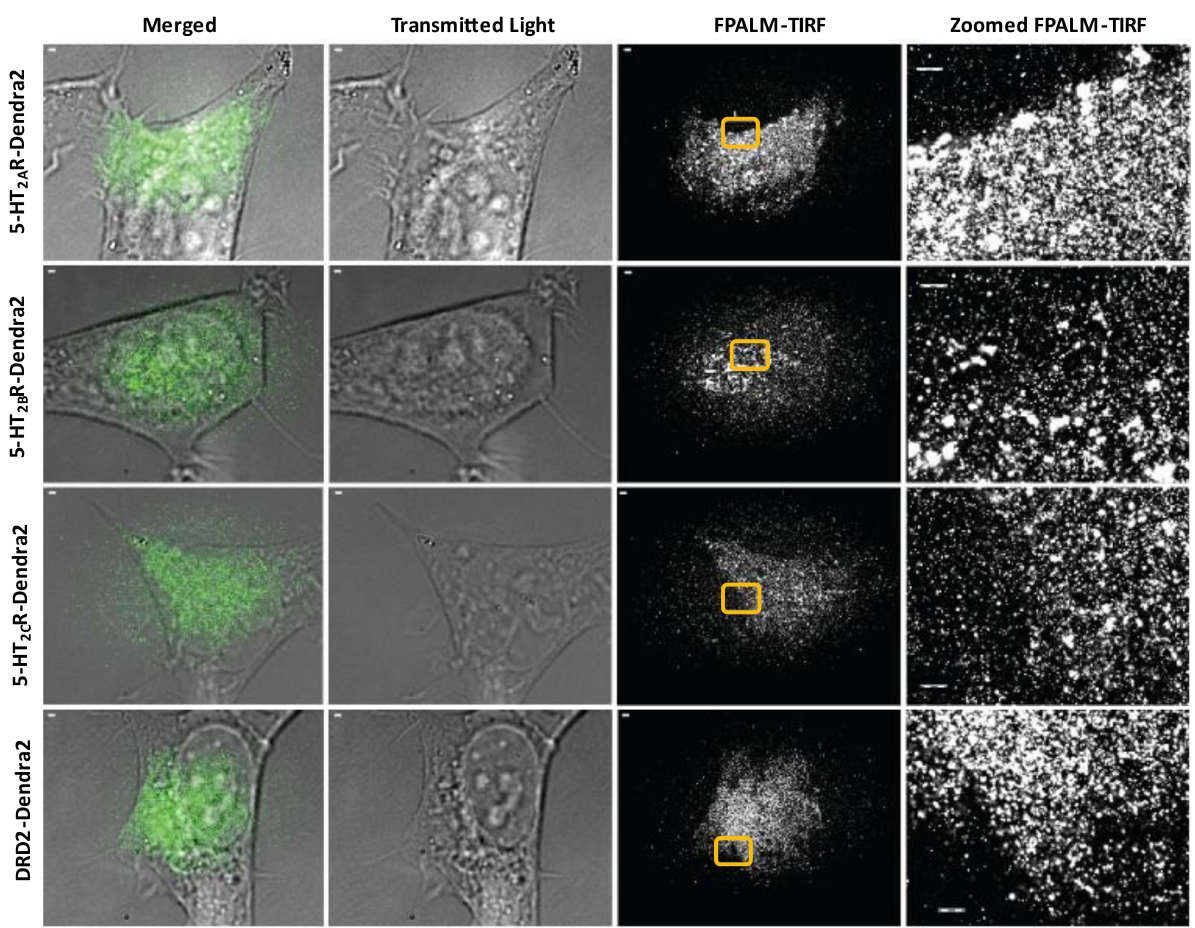
Figure 2. Surface expression of 5-HT 2 R-Dendra2 fusion proteins using FPALM-TIRF microscopy. HEK293A stable cells expressing 5-HT 2A R-Dendra2, 5-HT 2B R-Dendra2, 5-HT 2C R-Dendra2, and DRD2-Dendra2 (green) were analyzed using super-resolution localization microscopy (FPALM) with TIRF illumination (individually represented by each row). Columns represent images acquired using different channels, with column of merged images on the left followed by column of transmitted light images and column of FPALM-TIRF images for each sample. Rightmost column represents zoomed-in regions of interest (yellow box) in FPALM-TIRF images for individual samples. Images were obtained using an Olympus IX71 with 60 × 1.45 NA TIRFM objective, excitation with a 561 nm laser, and activation with a 405 nm laser. Raw image stacks were acquired with an Andor iXon EMCCD at a frame rate of 31 Hz and EM gain of 200. Scale bars = 1 µ